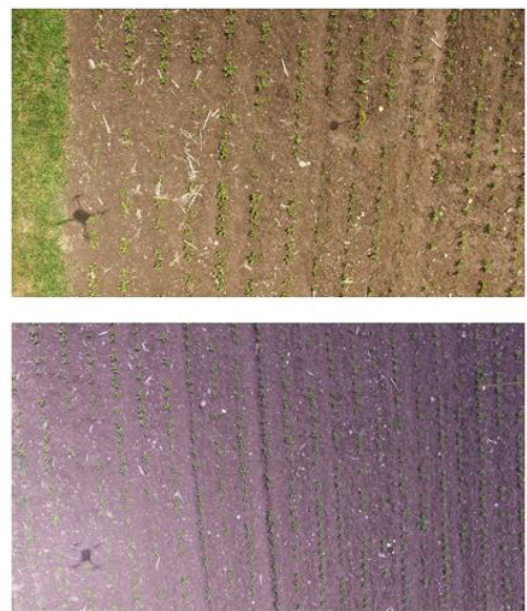
Fig. 1. Example of images from the used Database